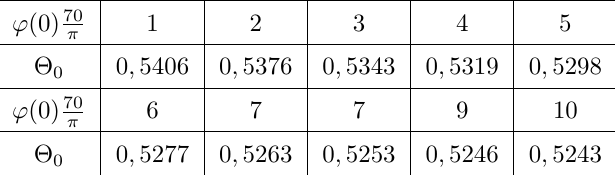
Table 8 . Length parameters for the non-abelian